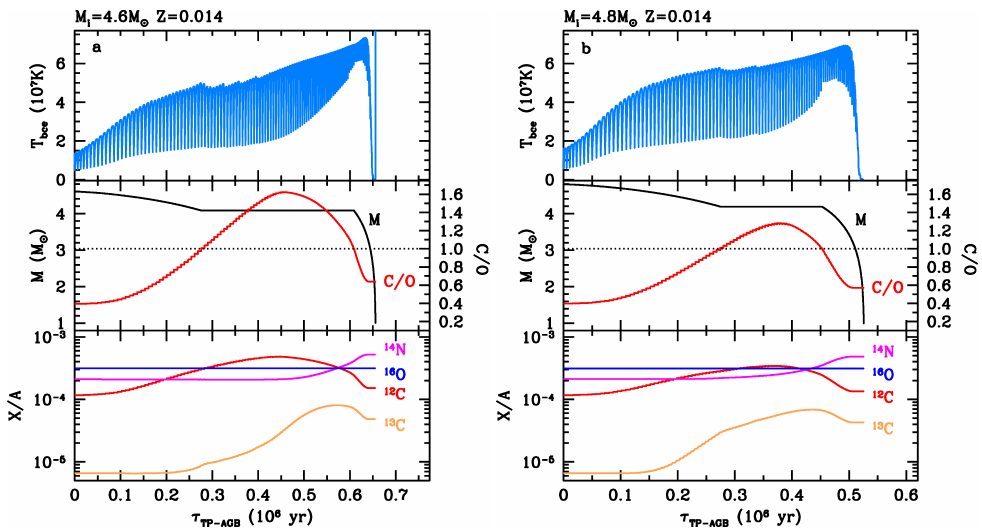
Figure 4. Structural properties of the Z = 0.014 models with M i = 4.6M (cid:12) ( a ), and M i = 4.8M (cid:12) ( b ). Moving downward, the panels show the evolution during the whole TP-AGB phase of the temperature, T bce , at the bottom the convective envelope (top panel), the current mass being reduced by stellar winds, and the photospheric C/O (middle panel), the surface abundance (in molar fraction X / A , where X is the mass fraction abundance, and A denotes the mass number of the species) of a few elements (bottom panel). The horizontal dotted line corresponds to C/O = 1. Note that the during the temporary C-rich stages the evolution proceeds at almost constant mass. See the text for more